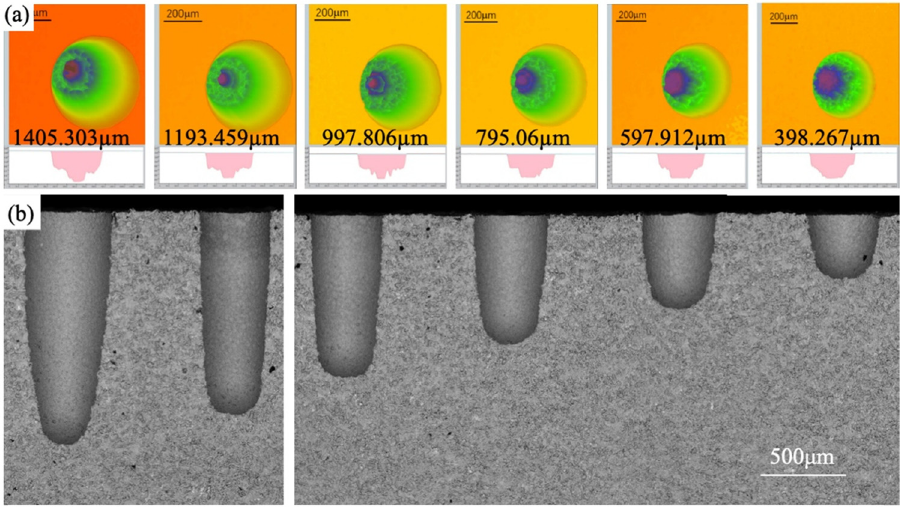
Figure 10: Blind holes processed by brass electrode: ( a ) the 3D morphology; ( b ) the SEM image ( frequency = 130 kHz, pulse width = 5 µs, current = 4.5, voltage = 90 V, gain coe ffi cient = 30 ) .